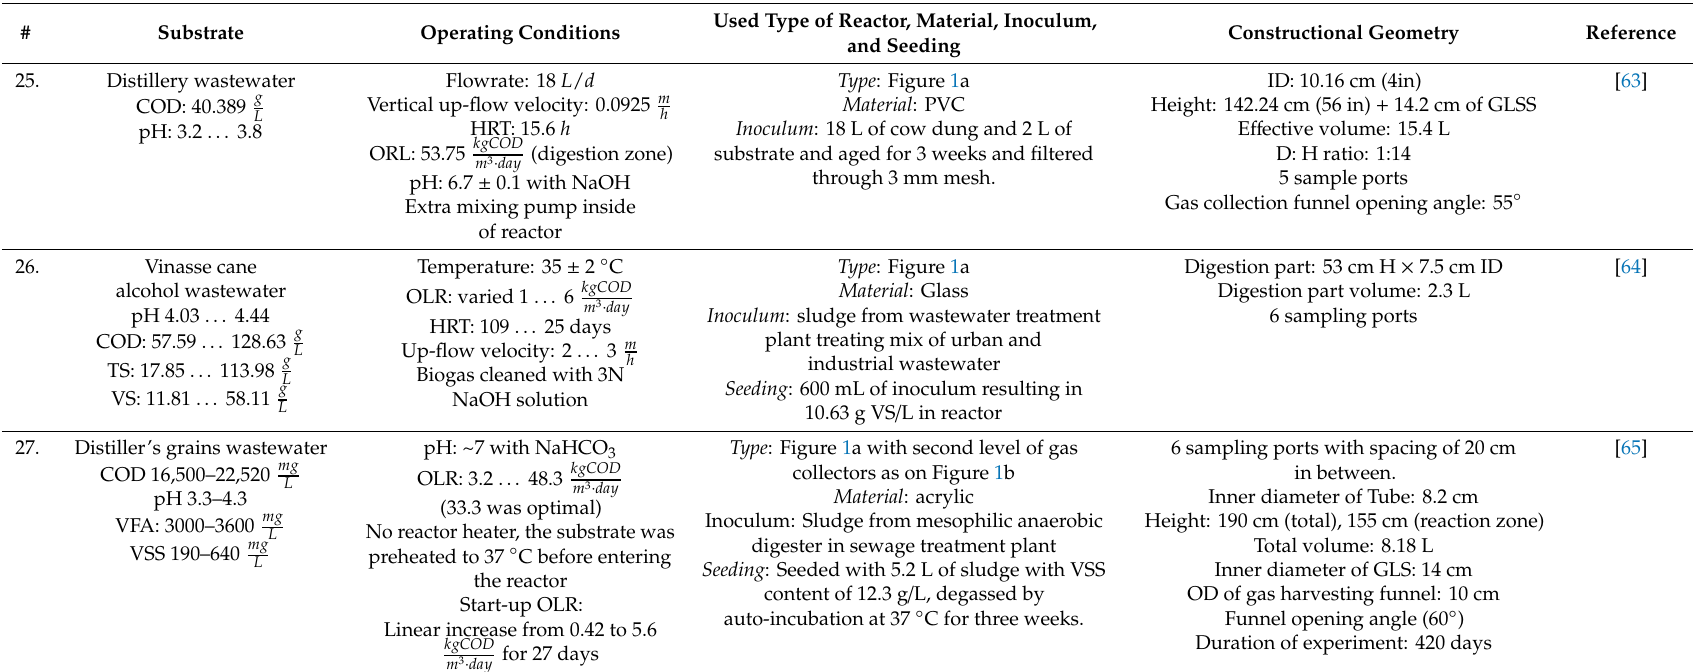
Type : Figure 1a with second level of gas collectors as on Figure 1b Material : acrylic Inoculum: Sludge from mesophilic anaerobic digester in sewage treatment plant Seeding : Seeded with 5.2 L of sludge with VSS content of 12.3 g / L, degassed by auto-incubation at 37 ◦ C for three